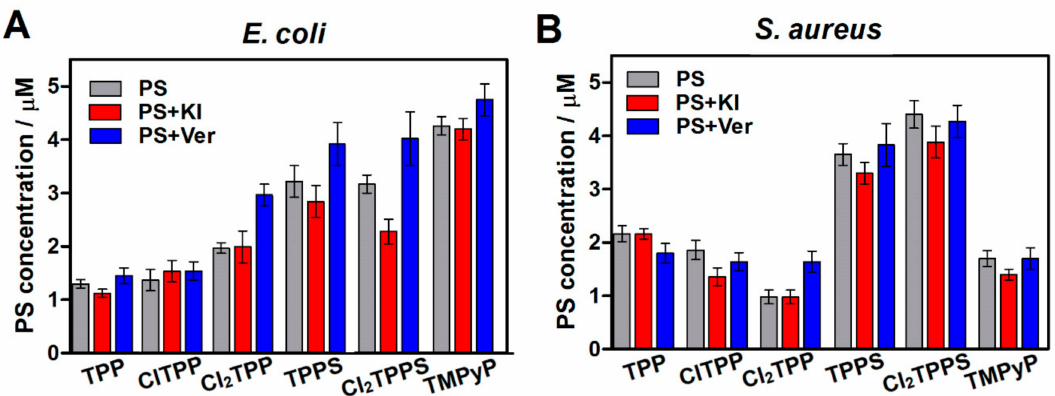
Figure 11. Uptake of PSs (with the initial 20 µ M concentration) by E. coli ( A ) and S. aureus ( B ) with verapamil and KI